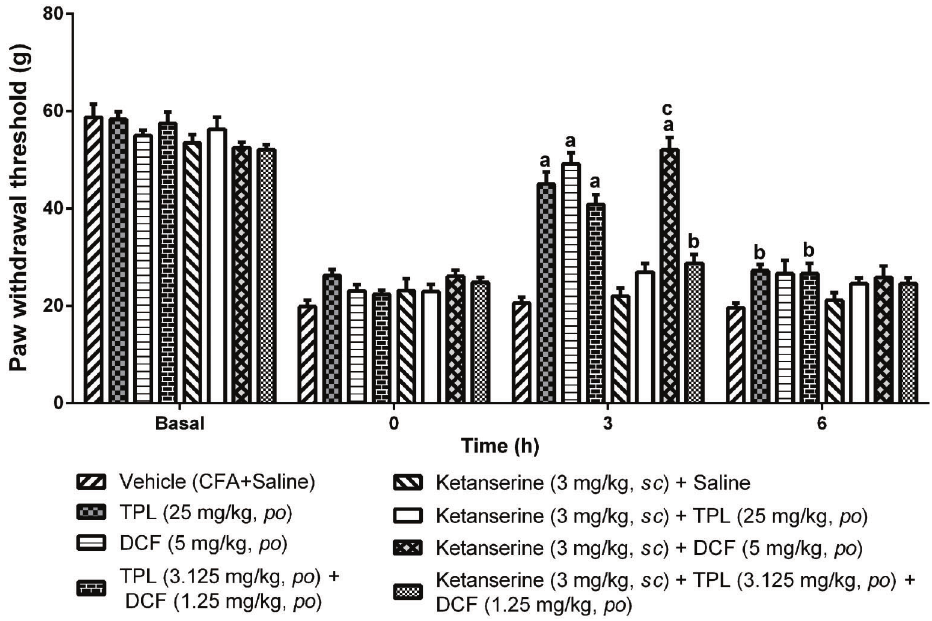
Figure 11. Involvement of the serotonergic system in the analgesic effect of terpinolene monoterpene (TPL)/diclofenac (DCF) combination in the mechanical compression test (Randall Selitto). Twenty-four hours after induction of in fl ammation by Freund ’ s complete adjuvant (CFA) in female Wistar rats (n=6 – 8), the groups were treated with ketanserin (3 mg/kg sc, 5-HT2A antagonist) and vehicle, and then 30 min later, with TPL (25 mg/kg, po ), TPL (3.125 mg/kg, po ) + DCF (1.25 mg/kg, po ) or DCF (5 mg/kg, po ) as positive control. Data are reported as mean ± SEM. a P o 0.001 and b P o 0.05 compared to saline group; c P o 0.001 compared to ketanserin + TPL group (two-way ANOVA, Bonferroni